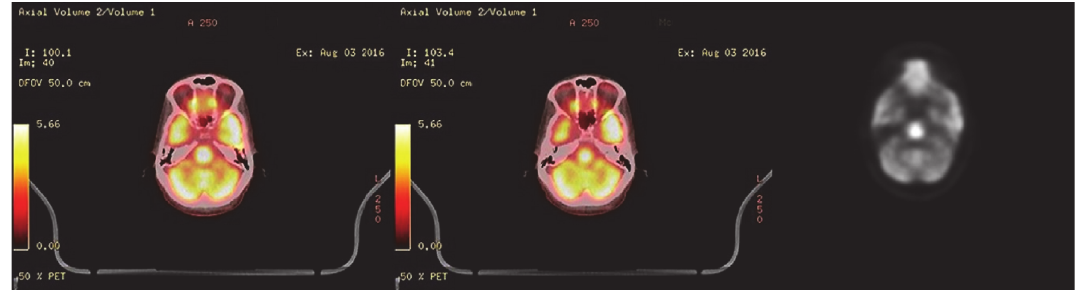
Figure 4: Head PET scan with F-fluorodeoxyglucose tracer on hospital day 14. Scans display focally intense hypermetabolic activity at the